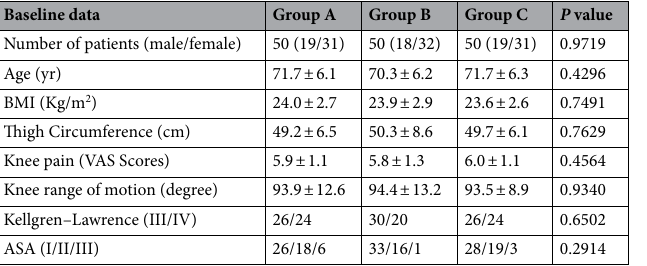
Table 1. Demographic and interoperation data among groups. Significant values are in italics. BMI, body mass index. VAS, visual analog scale. Kellgren-Lawrence, Kellgren-Lawrence Classification of Osteoarthritis. ASA, American Society of